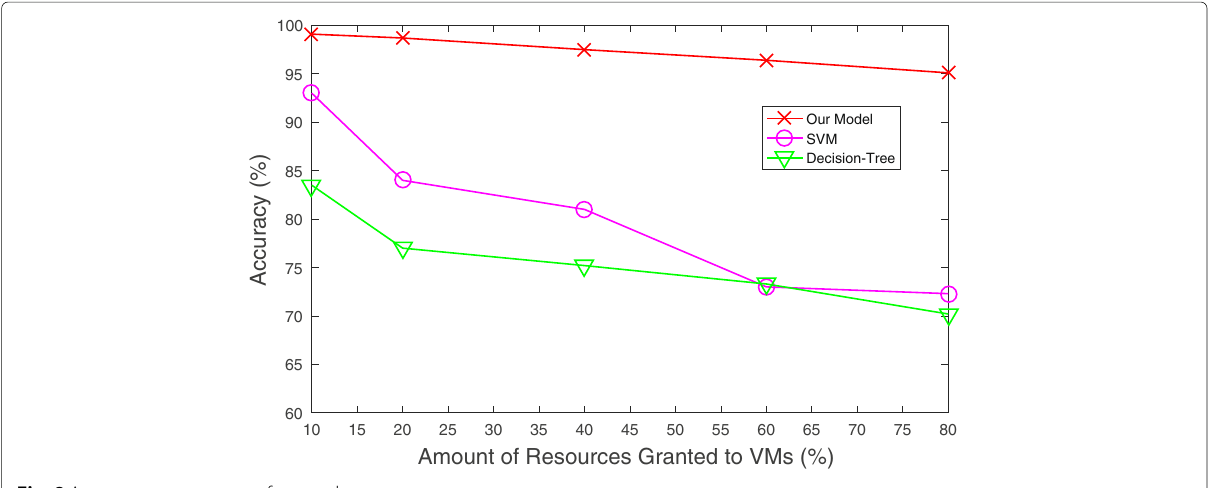
Fig. 8 Accuracy w.r.t. amount of granted resources